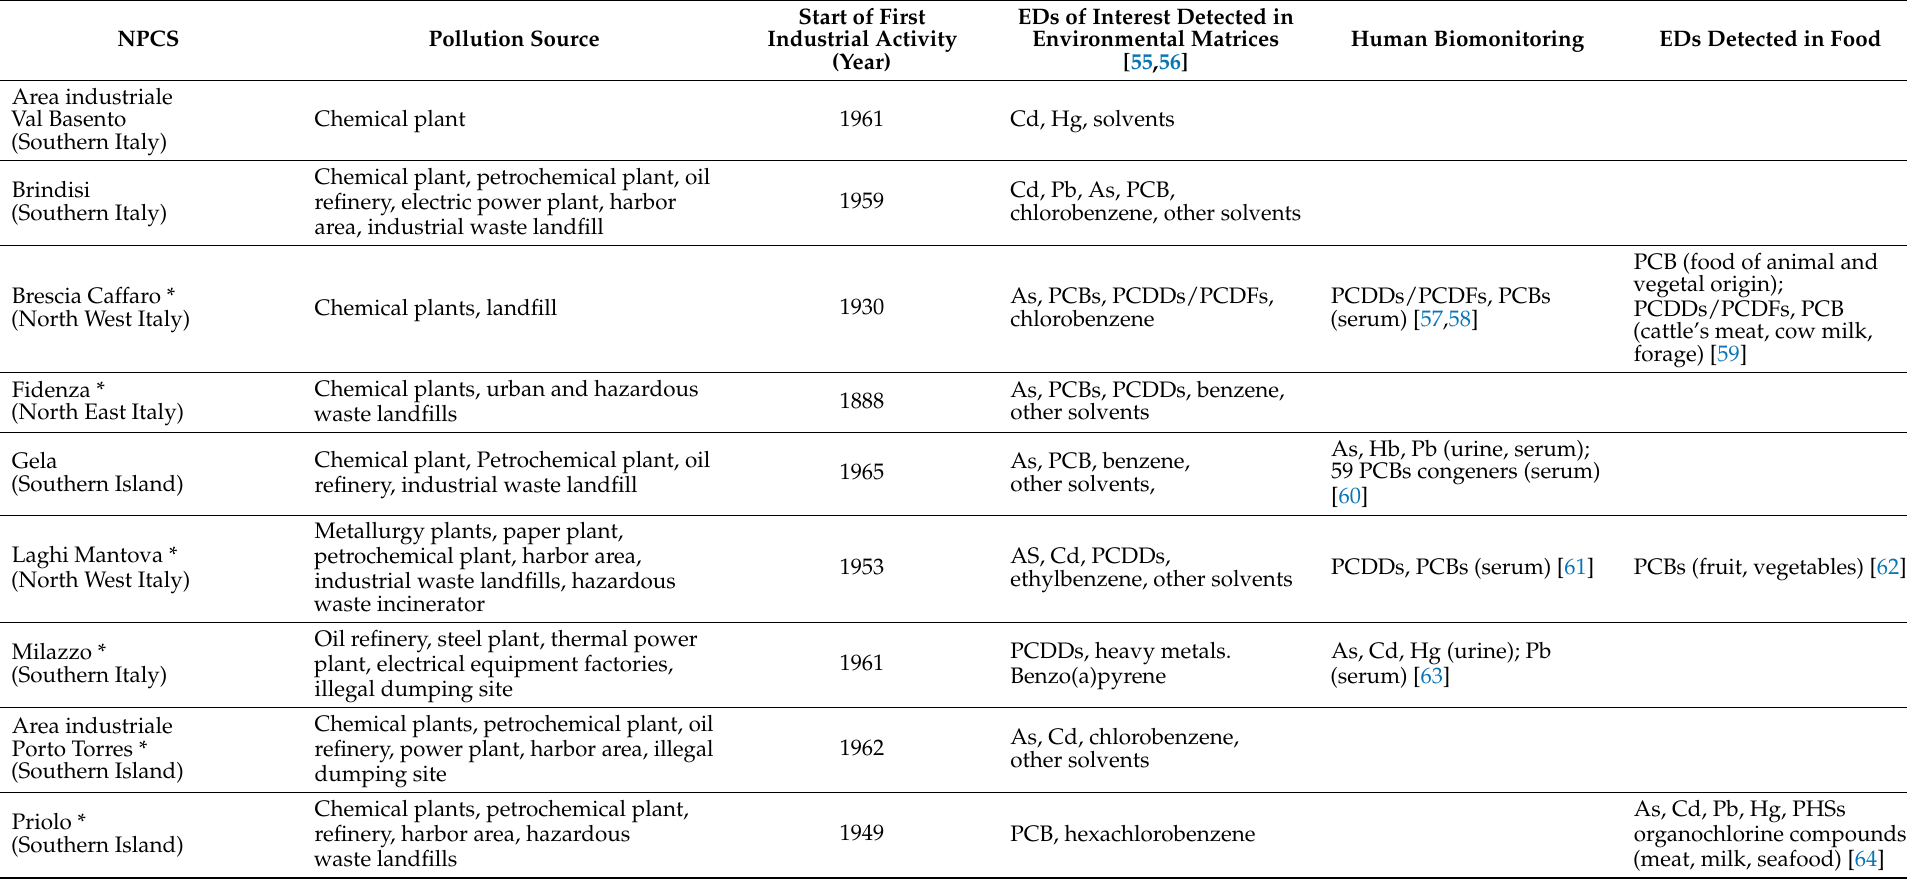
Table 1. National Priority Contaminated Sites (NPCS) information on pollution sources, year of start of first industrial activity, endocrine disruptors (EDs) of interest detected in environmental matrices, human biological samples, and